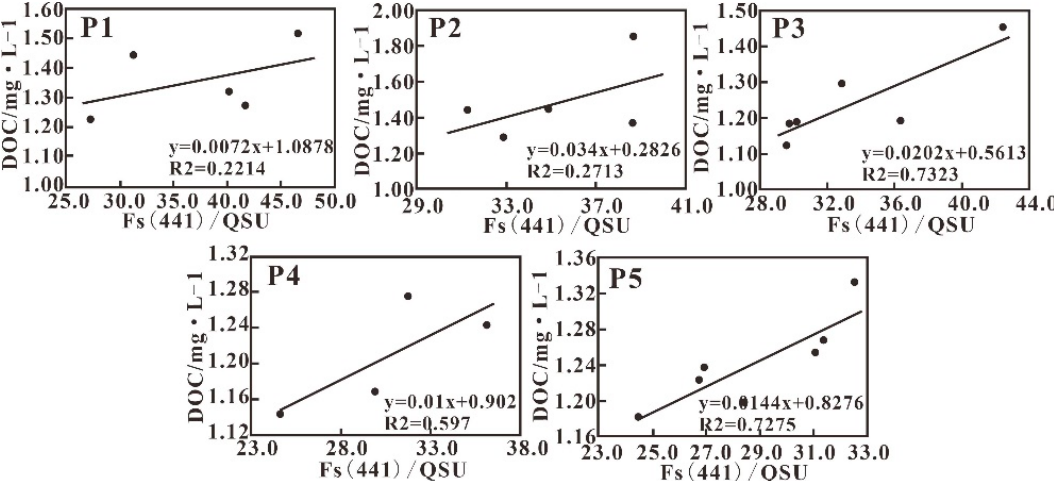
Figure 16. The relationship between fluorescence intensity and DOC along each transect.